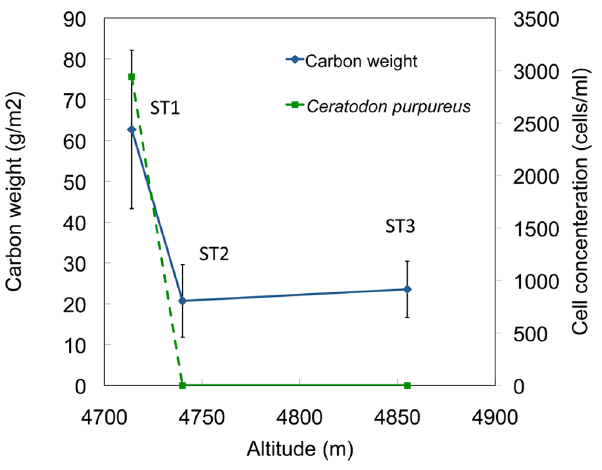
Figure 7. Distribution of carbon mass and Ceratodonpurpureus cell concentrations on Stanley Plateau